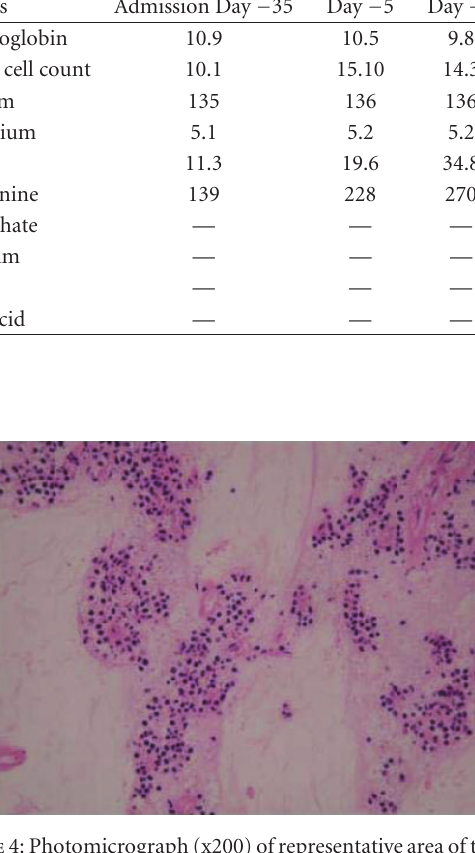
Figure 4: Photomicrograph (x200) of representative area of tumour at post mortem. Note the small pyknotic nuclei and areas of amor- phous myxoid stroma representing areas where the tumour cells have disappeared. Other areas were virtually